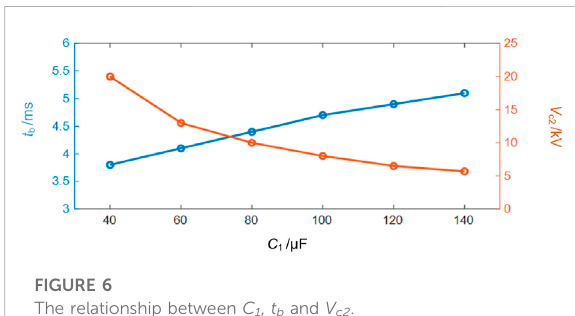
FIGURE 6 The relationship between C 1 , t b and V c2